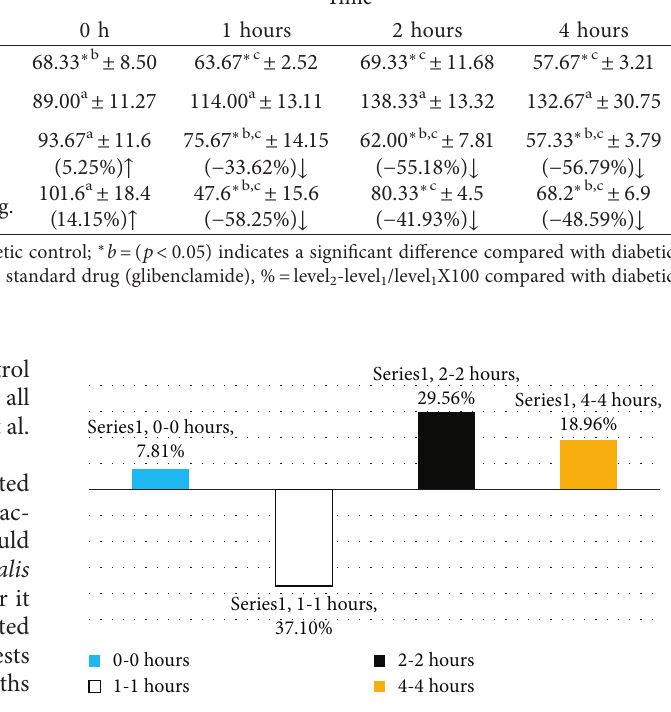
Table 6: Effects of Senna occidentalis (L.) Roots of 80% ethanolic extracts on glucose-loaded rats. Treatments